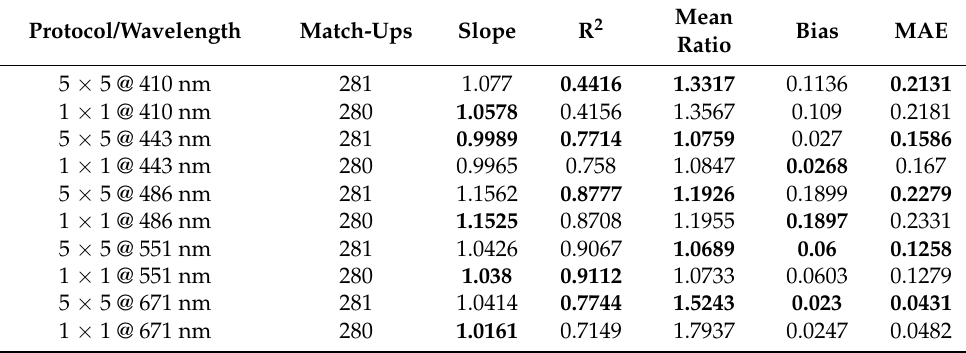
Table 3. Venise data, June 2014–May 2019. Permissive data protocol at 5 × 5 and 1 × 1 box sizes. Values closest to one in bold, for slope, R 2 , and mean ratio. Lowest values in bold for bias and mean absolute error.